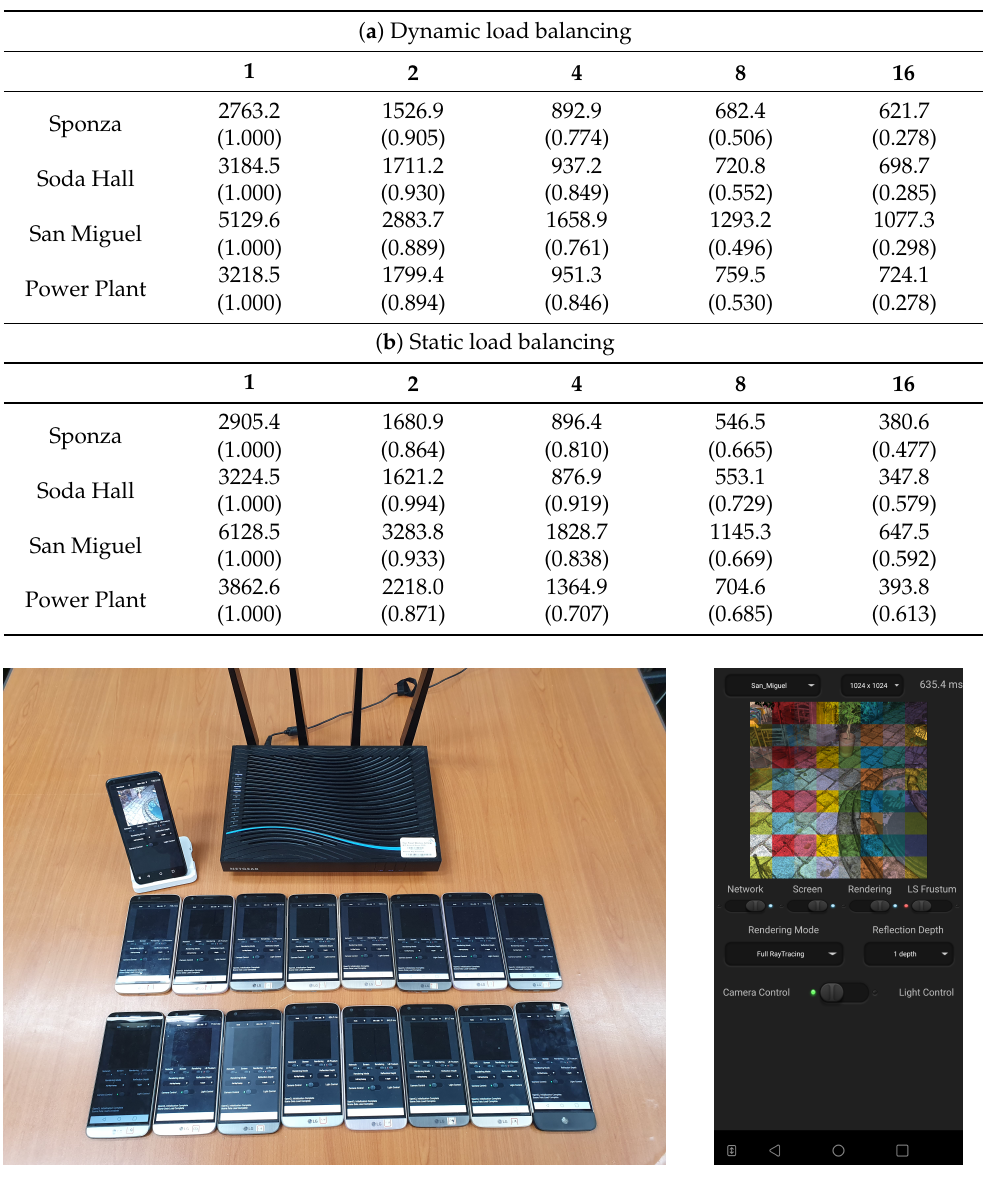
Figure 8. Our mobile distributed ray tracing system in action. ( a ) Sixteen worker devices participated in the distributed rendering of the San Miguel scene with high complexity. ( b ) Tile images that were produced by different worker nodes are overlaid in different colors to show the work